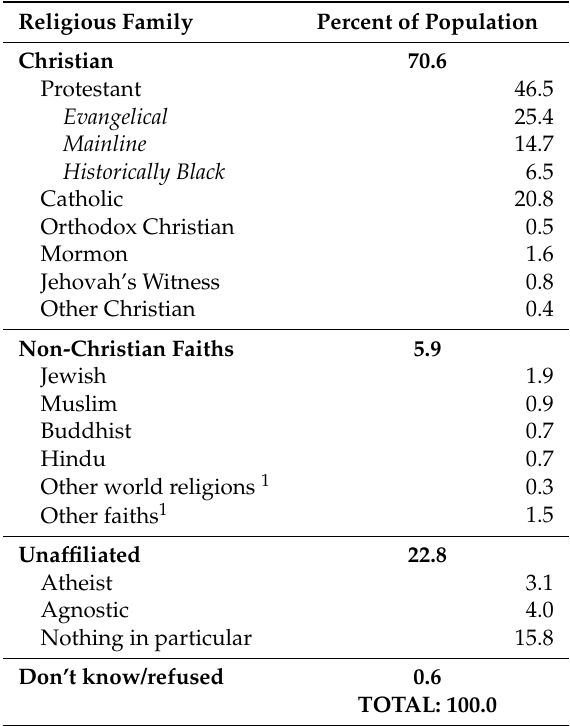
Table 1. Major Religious Traditions in the U.S. in